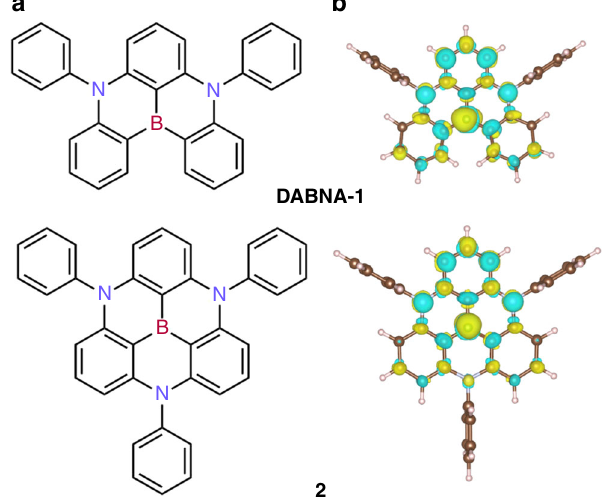
Fig. 1 Evidence for short-range charge transfer in boron-centered azatriangulene molecules. a Chemical structures and b difference density plots of DABNA-1 and 2 (summing over the two doubly degenerated S 1 states, see Supplementary Fig. 4). Yellow (blue) color indicates increased (decreased) electron density upon S 0 -S 1